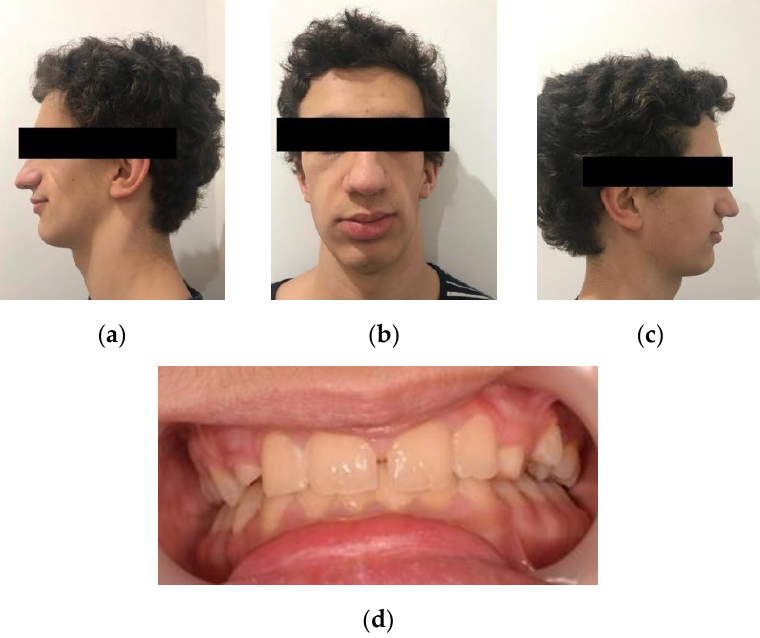
Figure 1. Extra-oral and intra-oral frontal photography. ( a ) Left side; ( b ) Frontal; ( c ) Right side; ( d ) Frontal intra-oral photography.